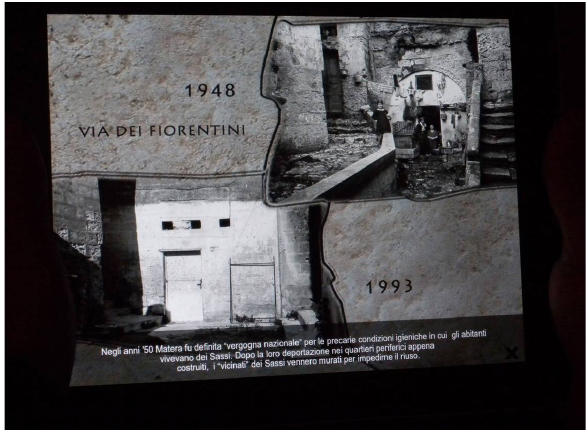
Figure 5. Historical photos taken from the same point of view, showing people living inside the Sassi neighbourhoods before 1950s and the same place after the